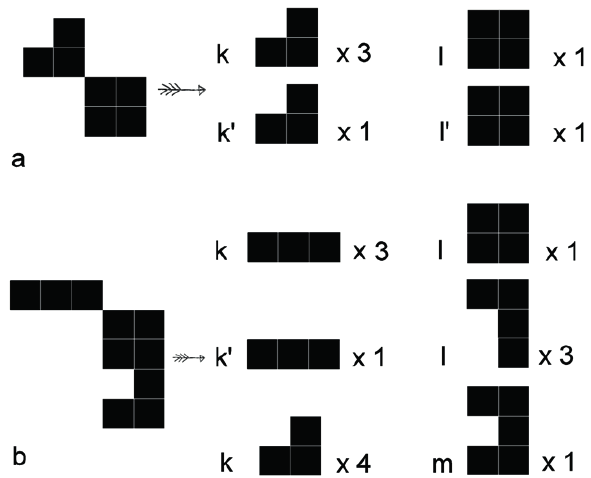
Figure 8. A schematic illustration of the assignment of k, k’, l, l’, m and m’ values in two hypothetic cases corresponding to the identi- cal shapes in (a) and (b) detected in both of the compared patterns, one derived from the pairwise cell distance matrices and another one derived from sona